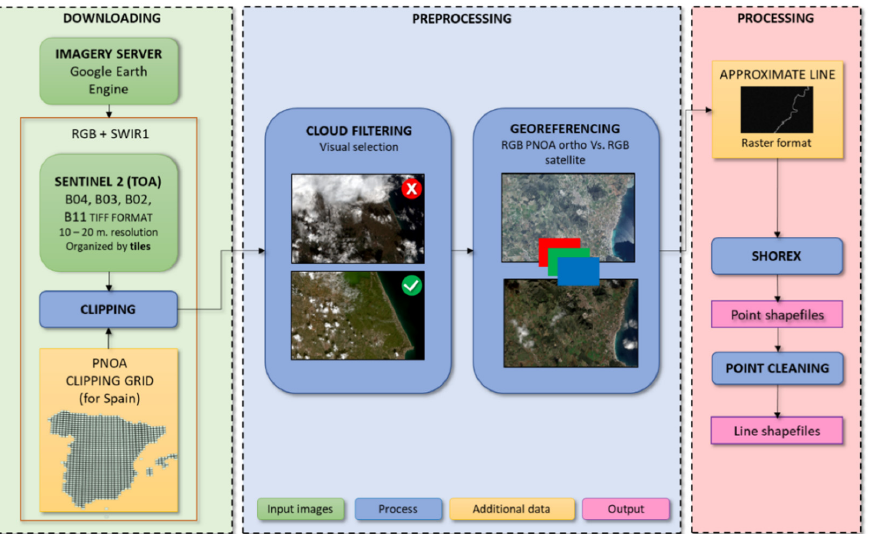
Figure 4. SHOREX workflow and its three main phases: downloading ( left ), preprocessing ( middle ), and processing ( right ).